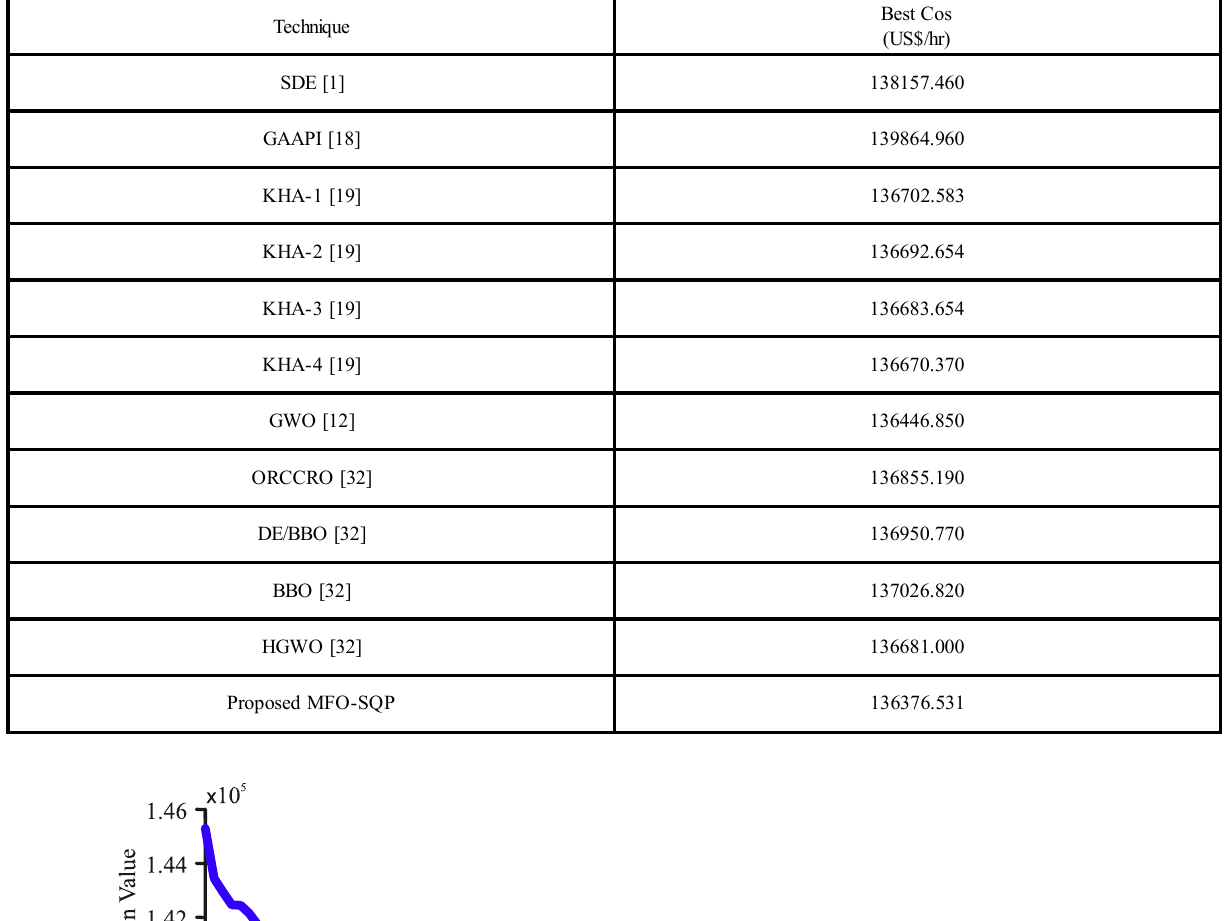
TABLE 6. COMPARISON OF 40 UNITS TEST SYSTEM (WITH LOSS)